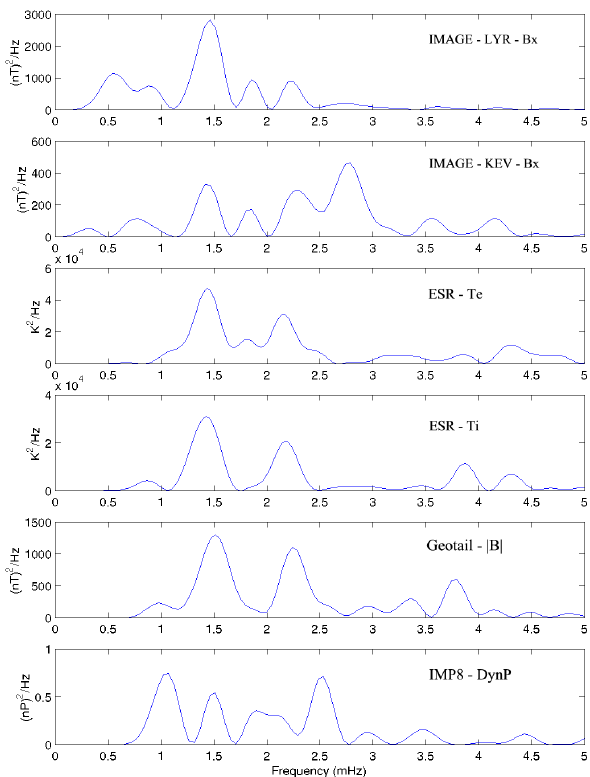
Fig. 7. Polarisation (negative values for clockwise polarisation; pos- itive for counterclockwise) and amplitudes X - and Y -components of the ground magnetic pulsations for three frequencies: 1.4 (plain), 1.8 (dotted), and 2.2mHz